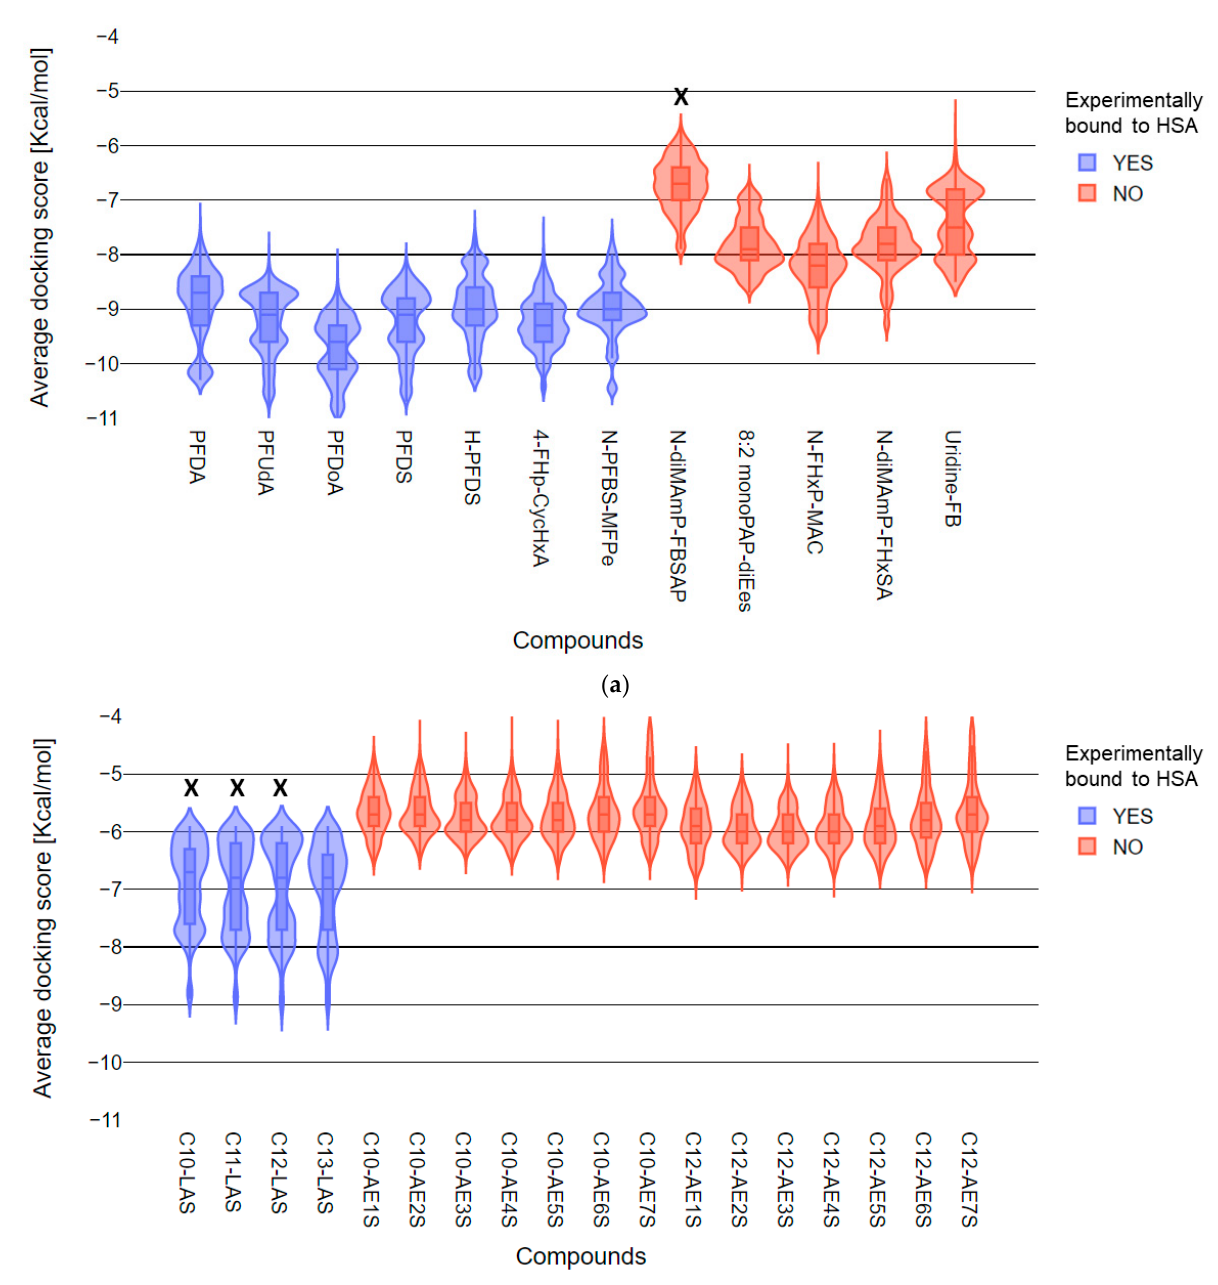
Figure 6. Violin plots of molecular docking simulated 1E7G docking scores for ( a ) PFAS with greater than 10 perfluorocarbons and ( b ) hydrocarbon surfactants identified in AFFF that have greater than 10 carbons. The shape of each violin represents a rotated kernel density plot of 5400 HSA–PFAS binding conformations generated from simulations for six binding pockets. Blue and red colors are used to distinguish experimental results. The compounds with significantly greater peak area (after correction with ISTD peak area) in the noncovalently bound fraction of the protein chamber relative to the chemical chamber are shown in blue. The compounds identified experimentally in the protein chamber that were not significantly greater in peak area relative to the chemical chamber are shown were red. Distributions in red were significantly different than distributions in blue Kruskal–Wallis ( p < 0.05) except for those distributions marked with a black X.